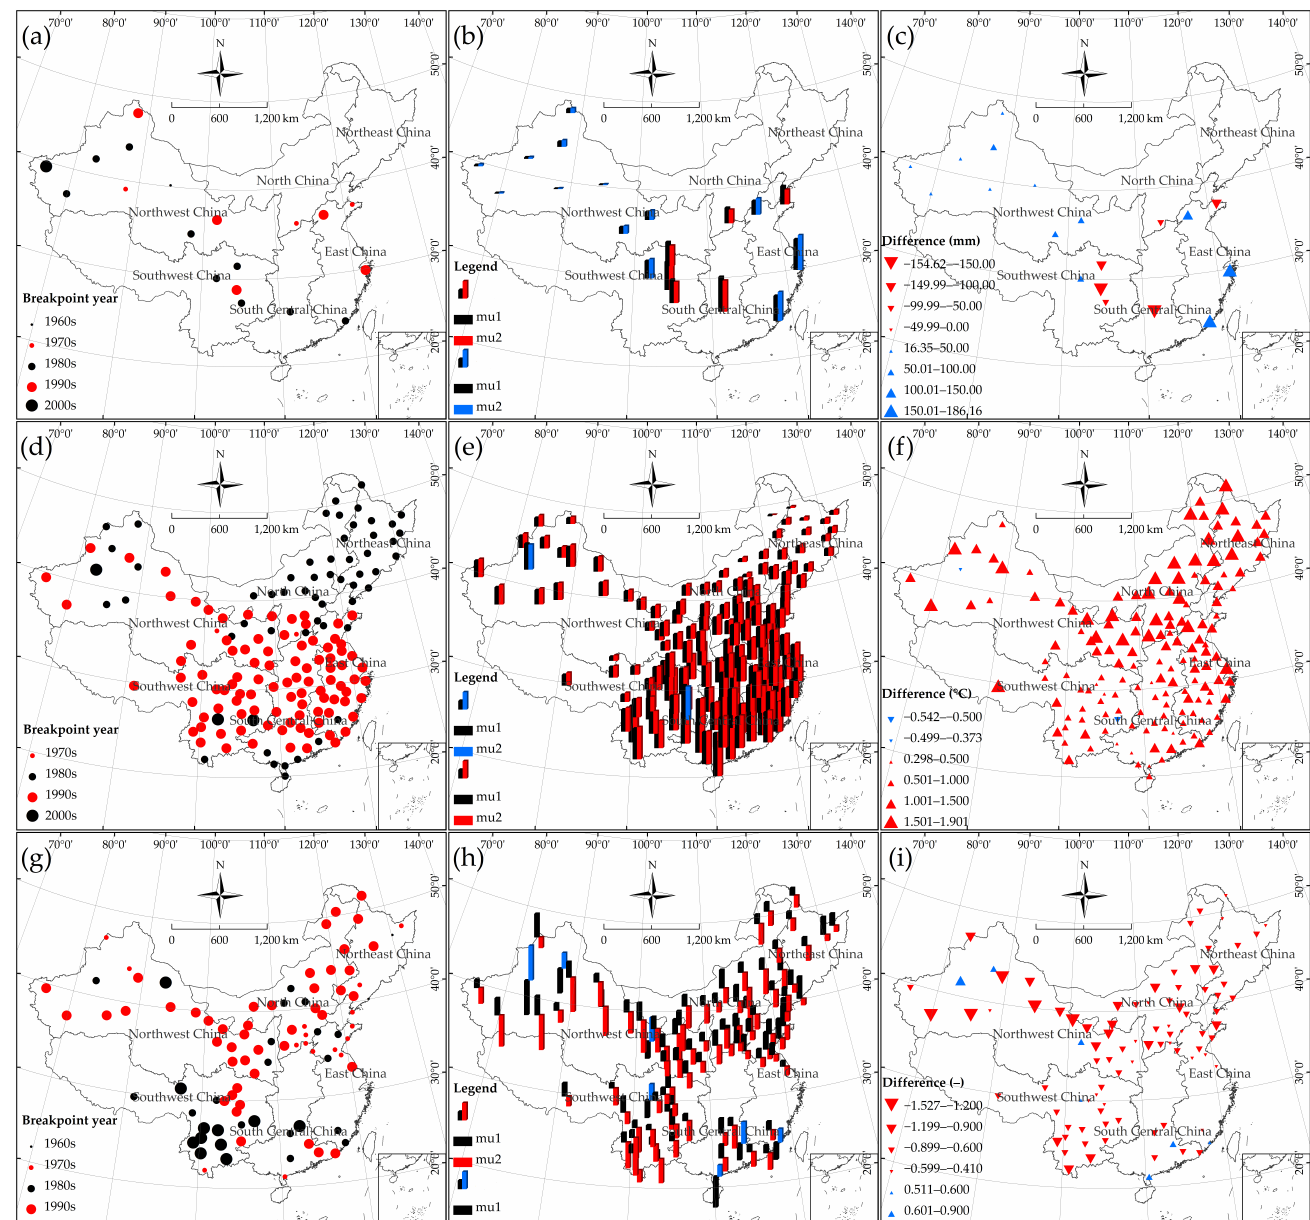
Figure 7. Spatial pattern of the breakpoint year for stations with significant change during 1951–2021: ( a ) precipitation; ( d ) temperature; and ( g ) the SPEI. Spatial pattern of the difference between post- and pre-mutation for stations with significant change during 1951–2021: ( b ) precipitation (red/blue means decrease/increase after mutation); ( e ) temperature (red/blue means increase/decrease after mutation); and ( h ) the SPEI (red/blue means decrease/increase after mutation). mu1 denotes pre- mutation; mu2 denotes post-mutation. The bar length indicates the variable’s magnitude. Spatial pattern of the difference value between post- and pre-mutation for stations with significant change during 1951–2021: ( c ) precipitation; ( f ) temperature; and ( i ) the SPEI. The meaning of the colors is the same as ( b , e , h ),